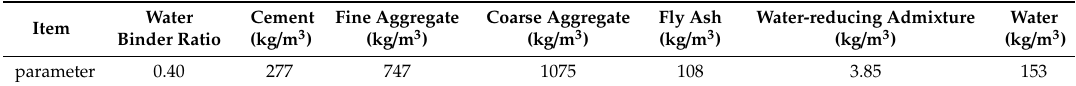
Table 5. Mix proportion of